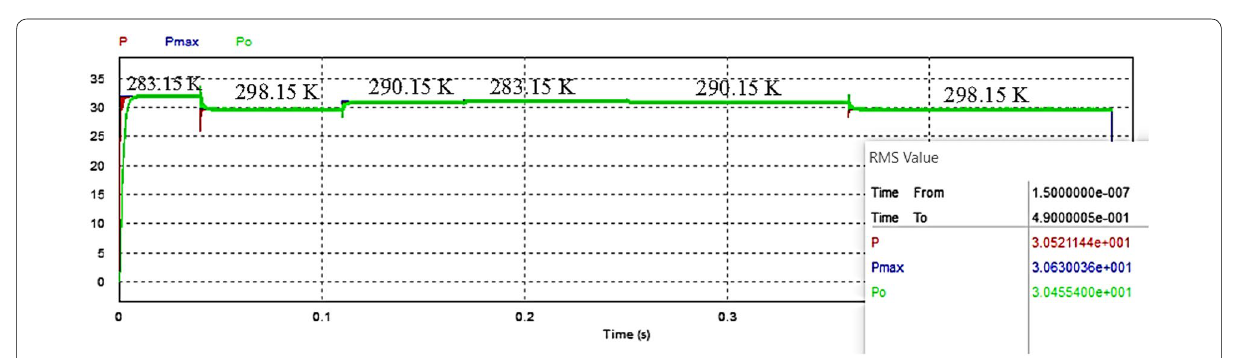
Fig. 15 Output powers for Kalman filter based MPPT under variable